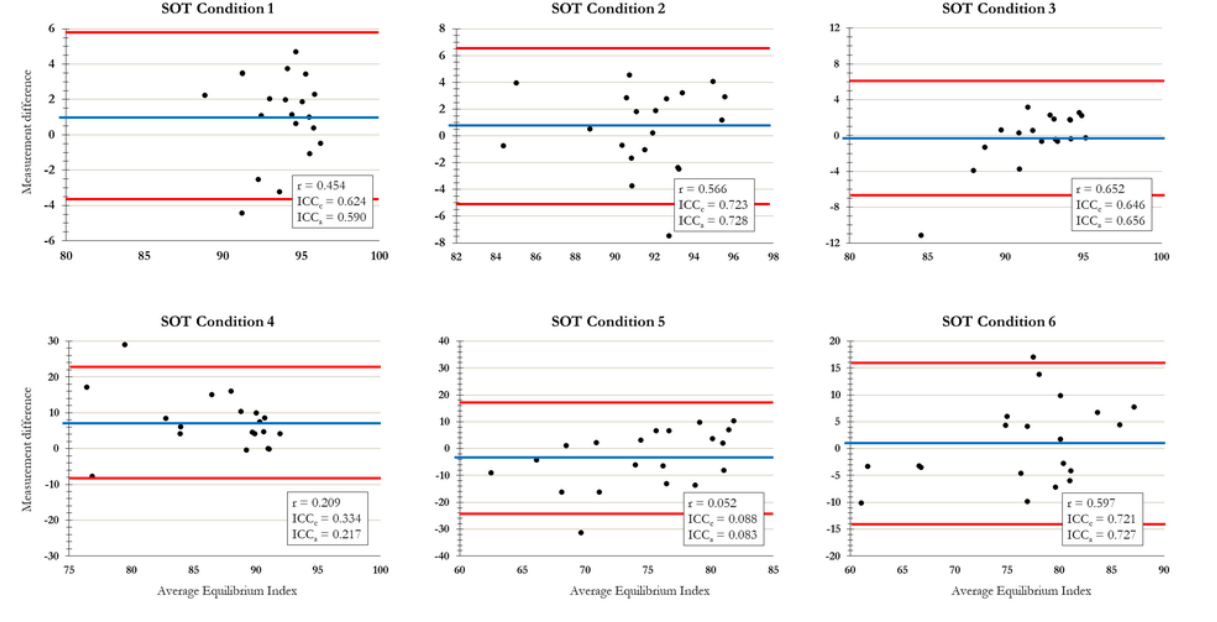
Figure 3. Bland-Altman plots comparing the equilibrium index and estimated equilibrium index from the Equitest and VR SOT, respectively. The Pearson correlation coefficient (r), intraclass correlation coefficient for absolute agreement (ICCa), and intraclass correlation coefficient for consistency (ICCc) are provided. SOT: sensory organization test; VR: virtual